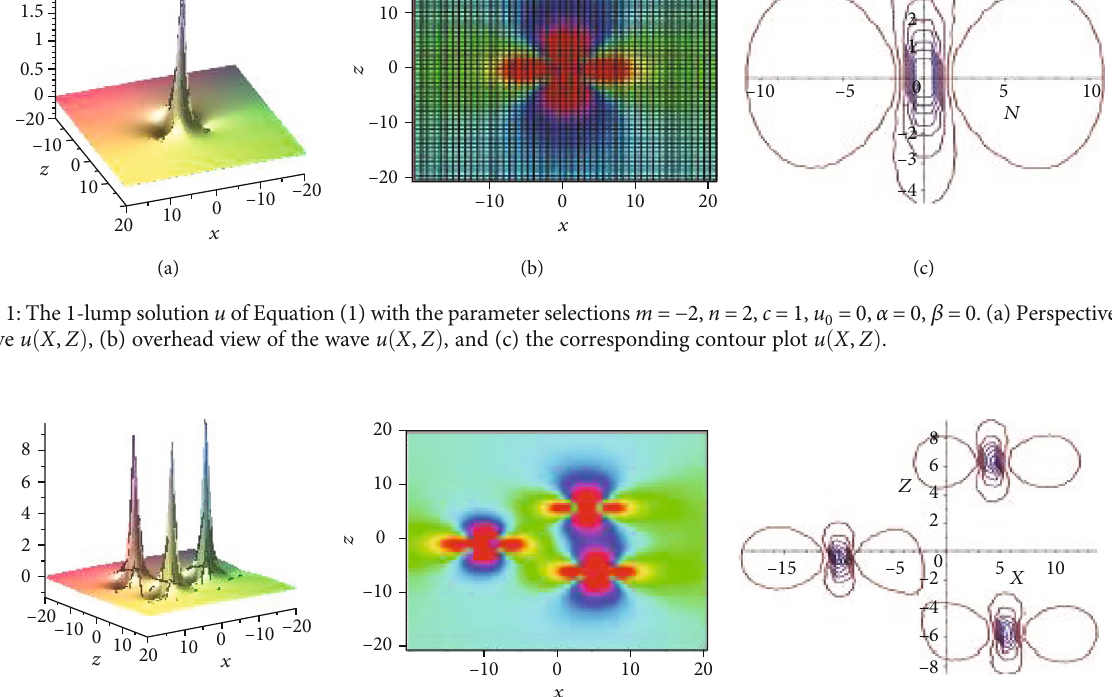
= 0, α = 1000, β = 1000, c = 1, 0 2,0